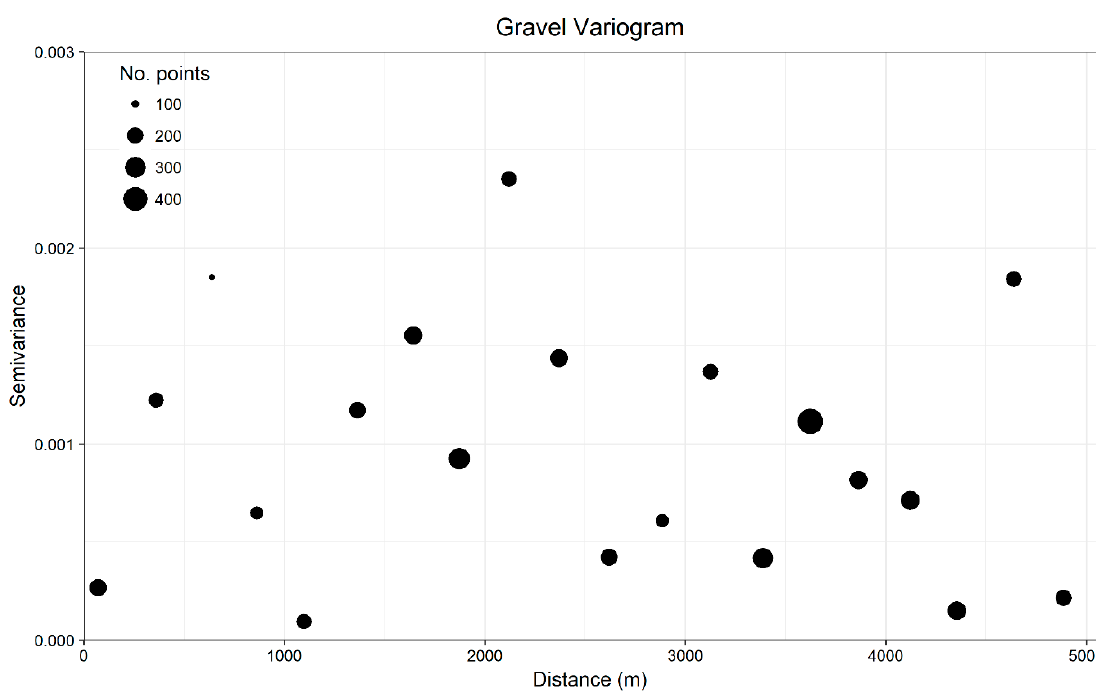
Figure A3. Gravel fraction variogram with 250 m lags.